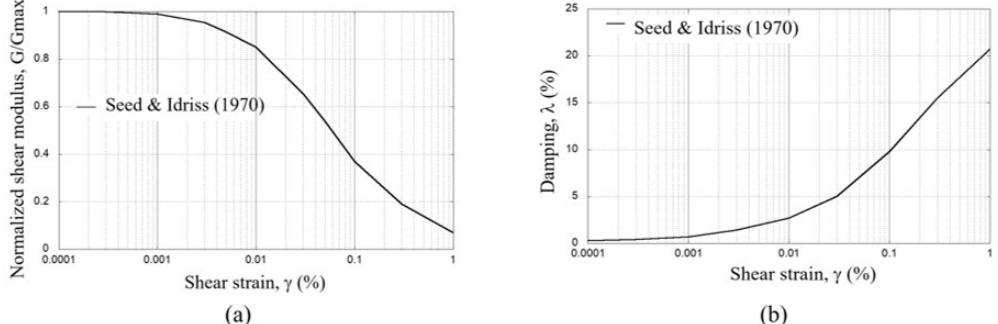
Figure 12. (a) Normalized shear stiffness curves G/G max and (b) damping curves λ .